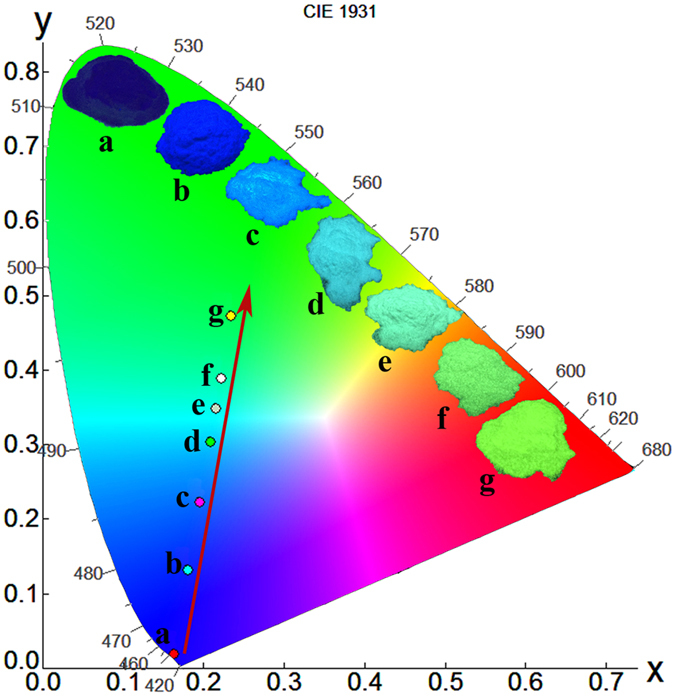
The CIE chromaticity coordinates of the NaBa3La3Si6O20:0.007Ce3+, yTb3+ phosphors (0 ≤ y ≤ 0.3) excited under 331 nm and the pictures of the NaBa3La3Si6O20:0.007Ce3+, yTb3+ phosphors (0 ≤ y ≤ 0.3) in a 365 nm UV box.